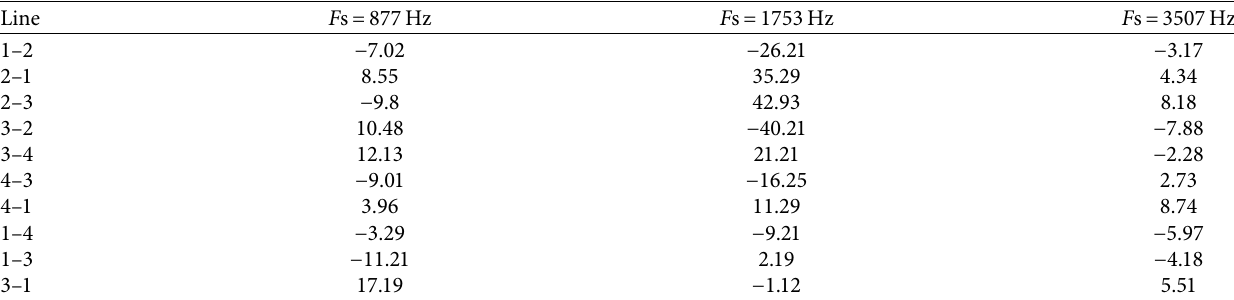
Figure 11: Nonradial network. Table 11: Nonradial network line power flow with